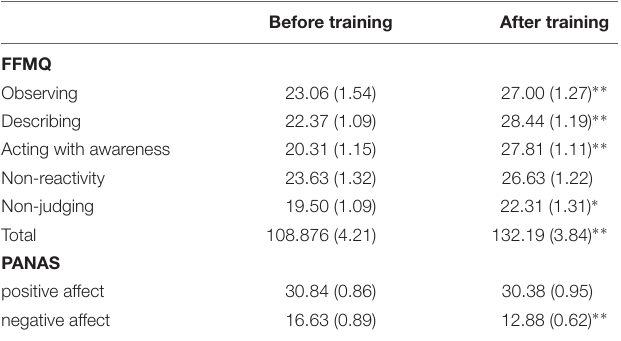
TABLE 3 | The five facet mindfulness questionnaire (FFMQ) and positive and negative affect schedule (PANAS) scores before and after meditation training. Before training